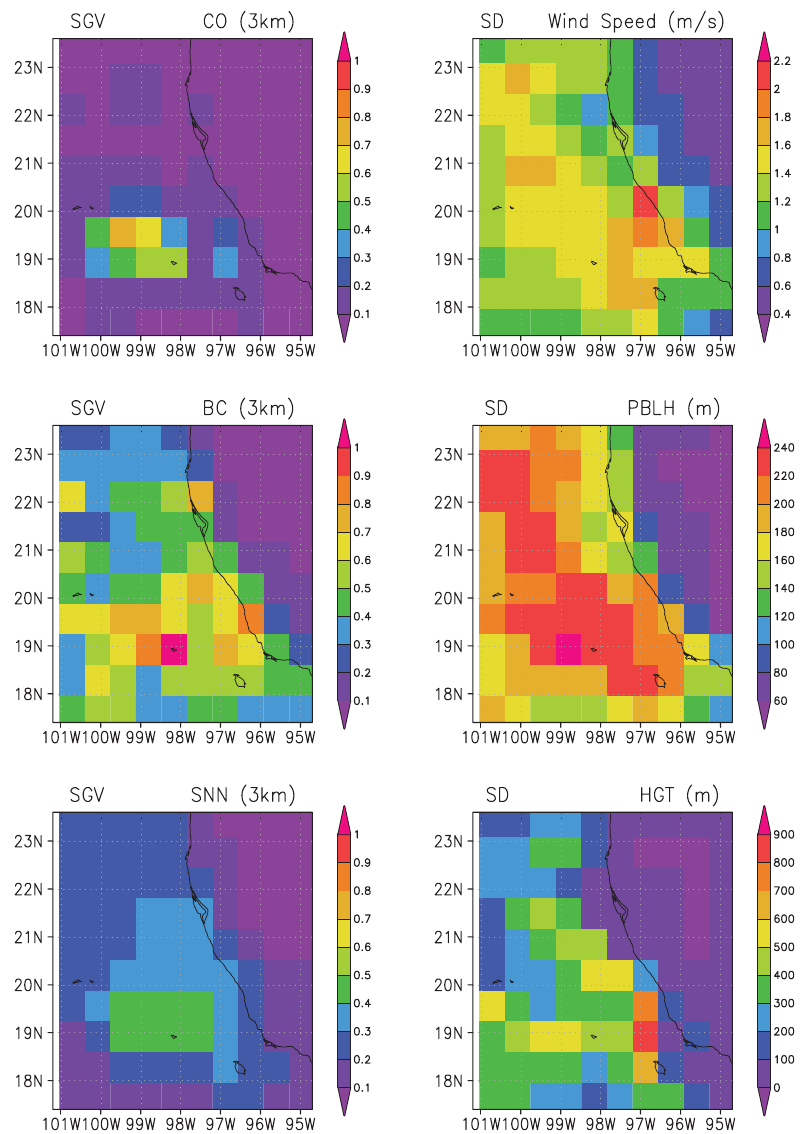
Fig. 10. The spatial distribution of SGV for the 3-km simulation within each 75-km grid cell from the coarser domain for bottom model level CO (ppb), BC (µgkg − 1 ) , and SNN (µgkg − 1 ) (left column) and of Standard Deviation (SD) for wind speed (ms − 1 ) , PBL height (m), and terrain elevation (m) (right column). The SGV here is averaged over the time period 5–30 March